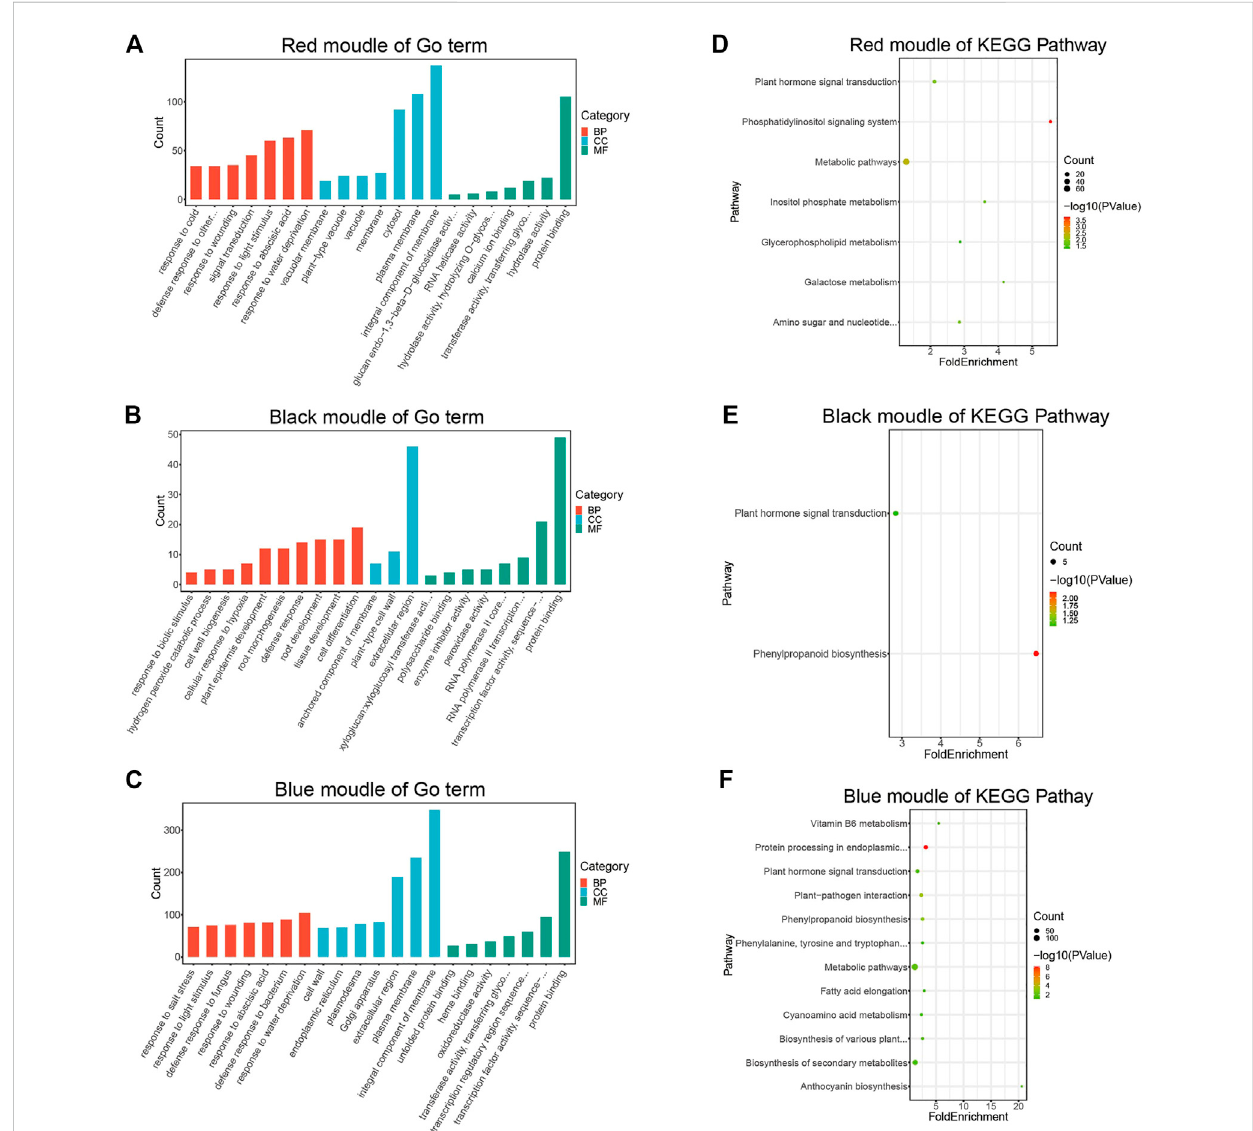
FIGURE 4 GO and KEGG enrichment analysis diagram. (A) GO Enrichment results of genes in the red module. (B) GO enrichment results of genes in the black module. (C) Enrichment results of genes in the blue module. (D) KEGG pathway enrichment results of genes in the red module. (E) KEGG pathway enrichment results of genes in the black module. (F) KEGG pathway enrichment results of genes in the blue